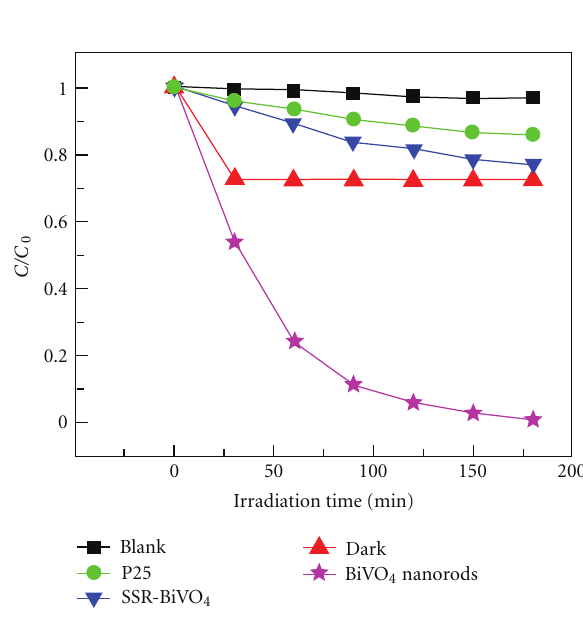
Figure 5: Photodegradation e ffi ciencies of the MB as a function of irradiation time for di ff erent